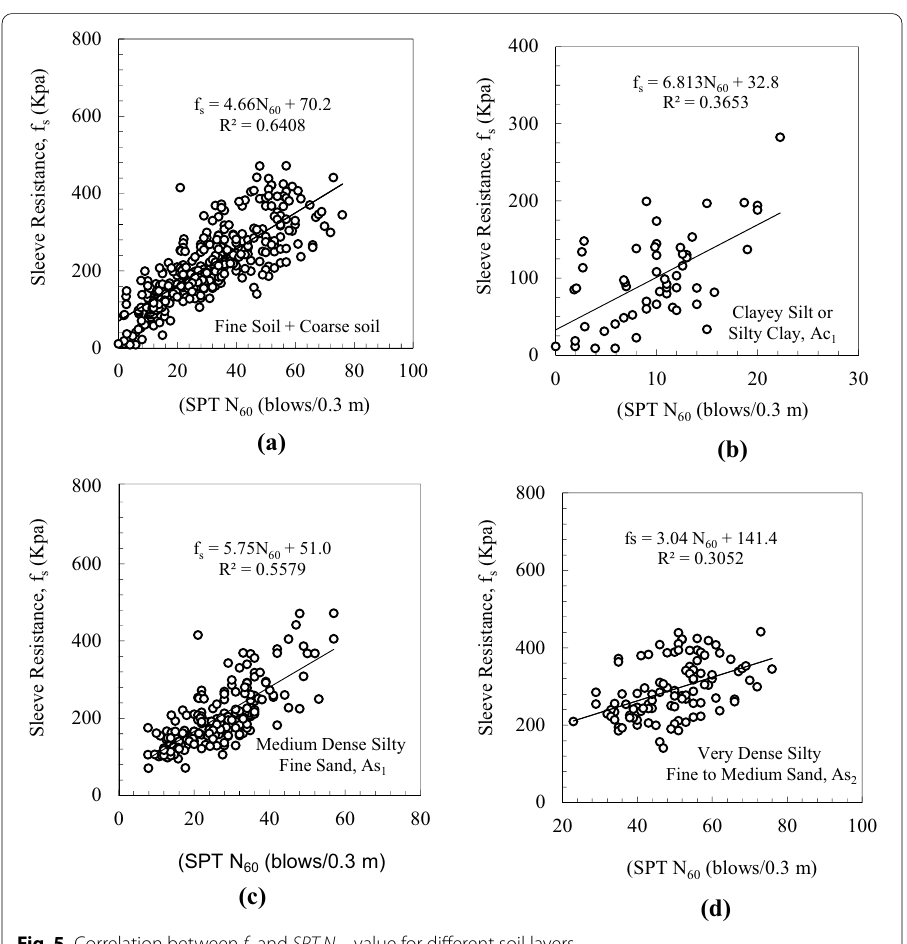
Fig. 5 Correlation between f s and SPT N 60 -value for different soil